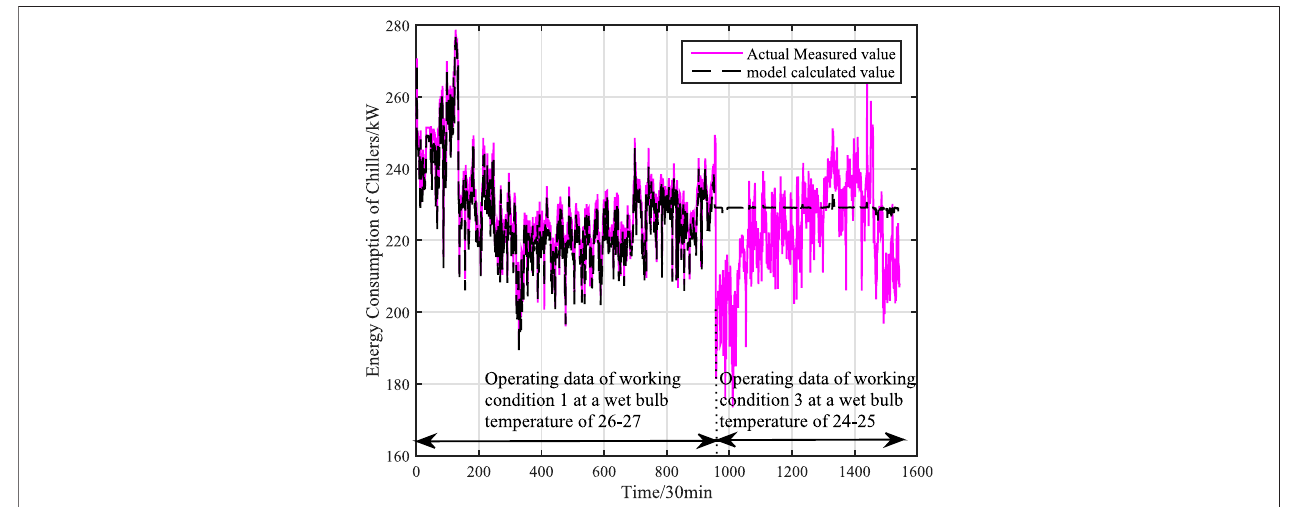
FIGURE 10 | The accuracy of KPLS model under multiple working conditions (working condition 1 and working condition 3).